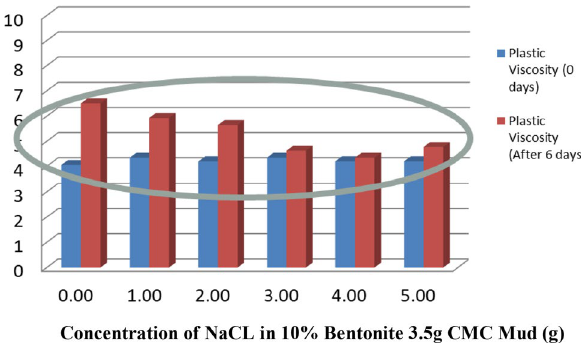
Fig. 8 Effect of NaCl, KCl and haematite on gel strength (after 10 min) of CMC–bentonite mud